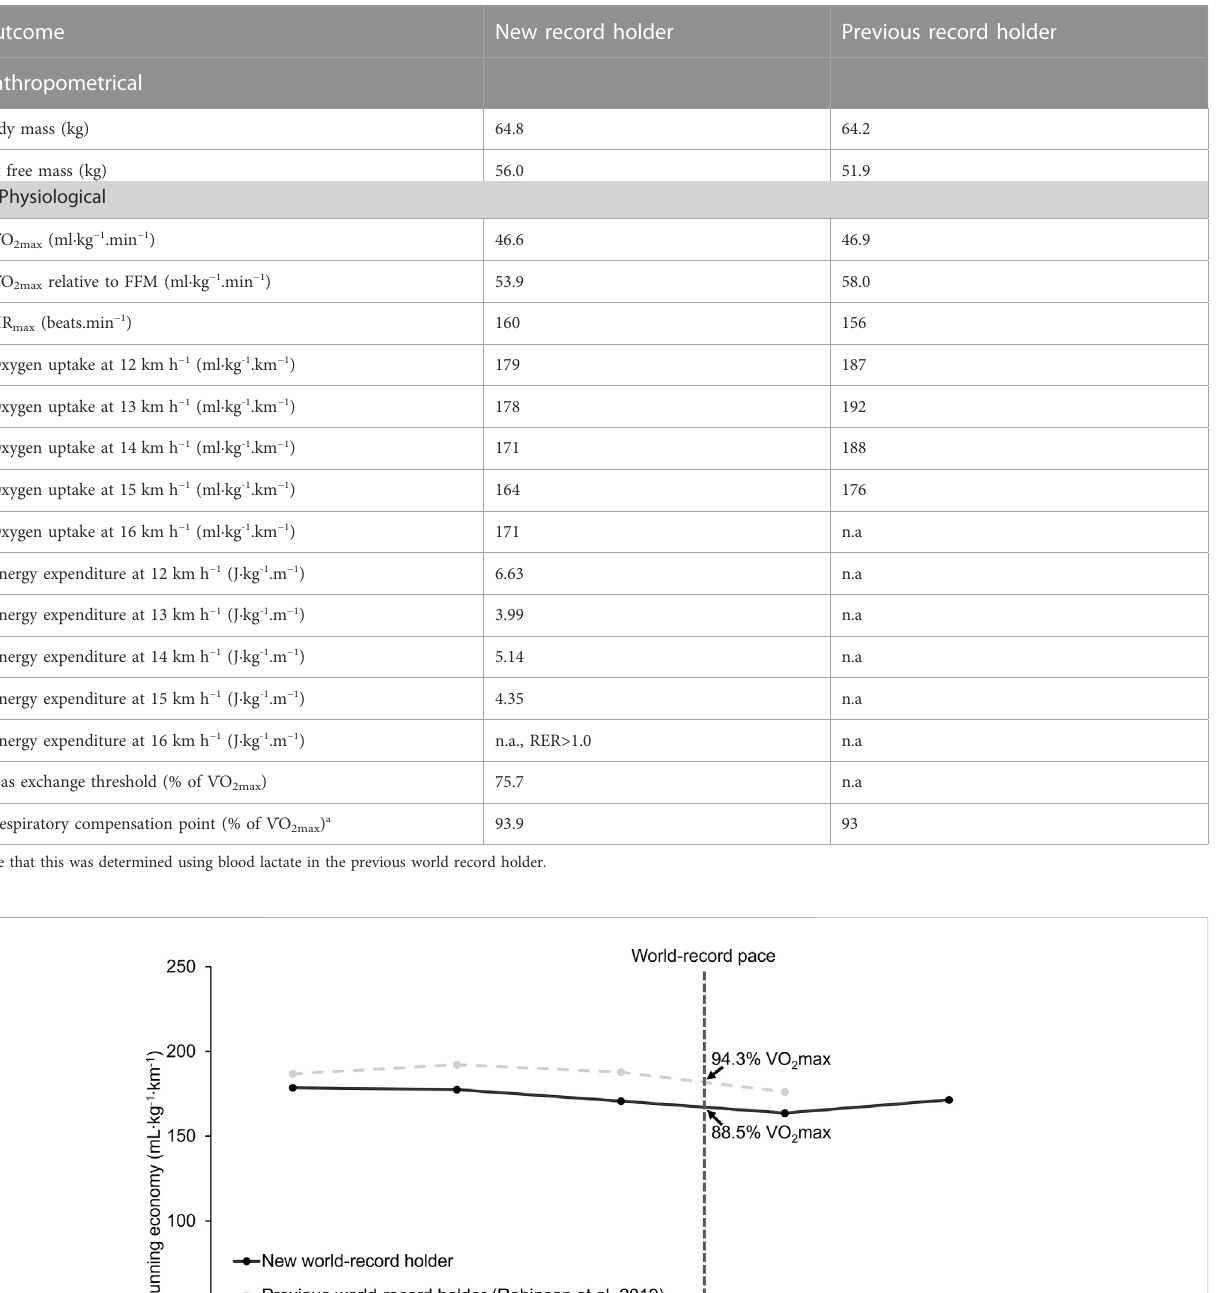
TABLE 2 Anthropometrical and physiological variables of the current and previous world record holder.